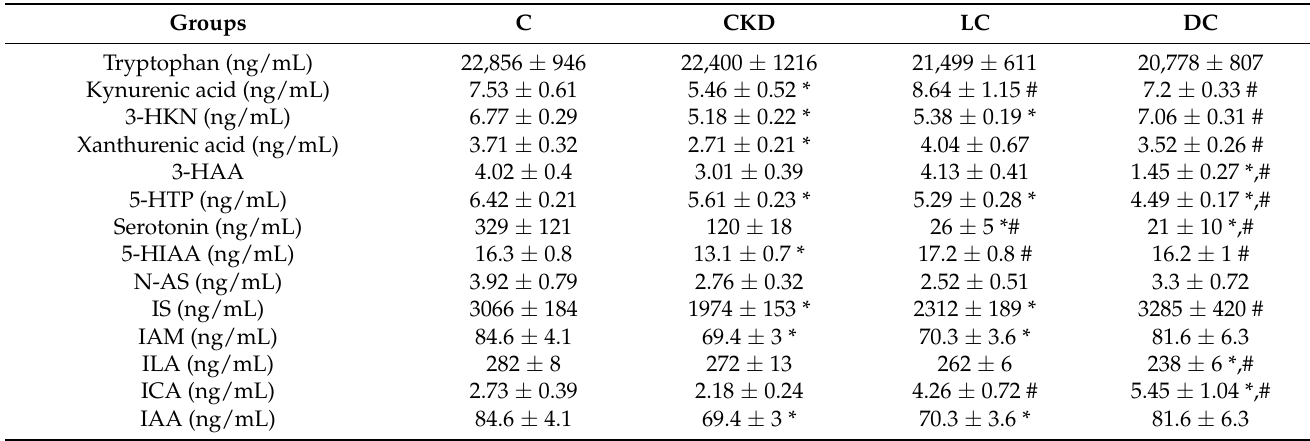
Table 3. Plasma levels of tryptophan